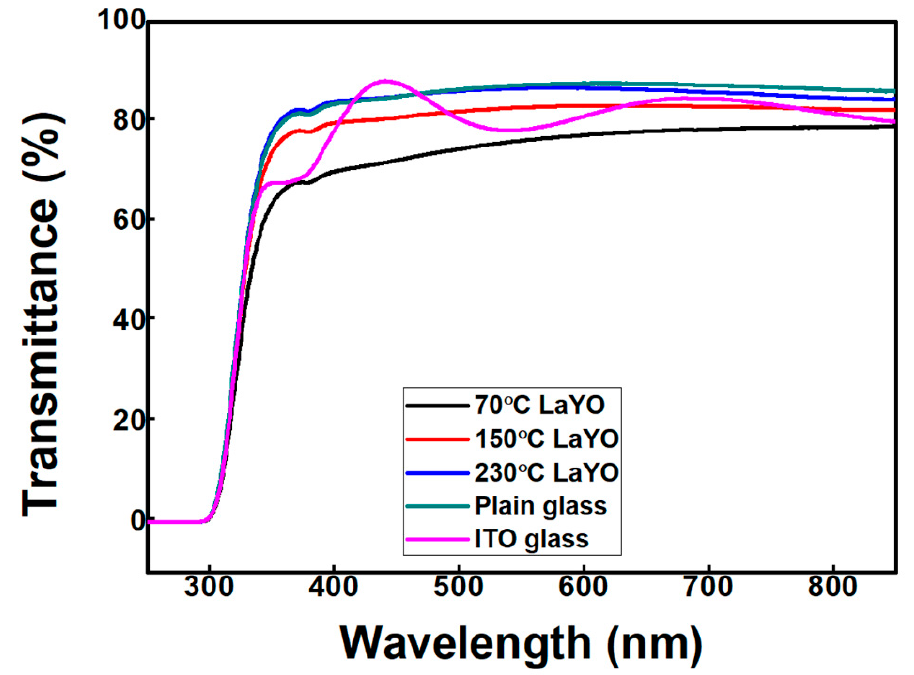
Figure 4. Optical transparency graphs acquired from the brush-coated nickel yttrium oxide films, plain glass, and indium-tin-oxide-coated glass.